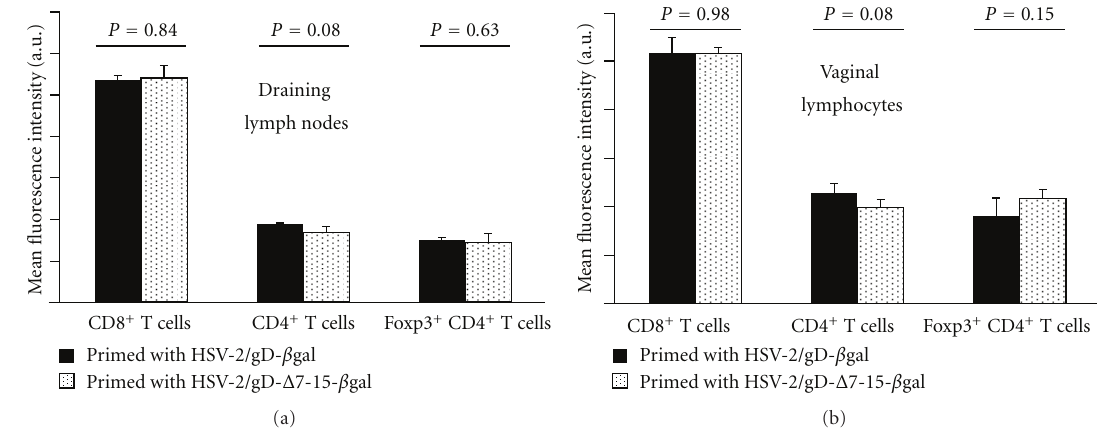
Figure 6: CXCR3 expression on CD8 + , CD4 + , and Foxp3 + CD4 + T cells does not statistically di ff er between groups of mice primed with viruses that can (HSV-2/gD- β gal, black bars) or cannot (HSV-2/gD- Δ 7-15- β gal, stippled bars) engage HVEM. Gates were chosen to exclude nonspecifically labeled cells based on isotype control antibody staining. Data are expressed as mean fluorescence intensity (MFI) of the indicated cell population from 3-4mice per condition, plus the standard deviation. P values reflect di ff erences in mean CXCR3 MFI for each cell population between groups of mice primed with the di ff erent